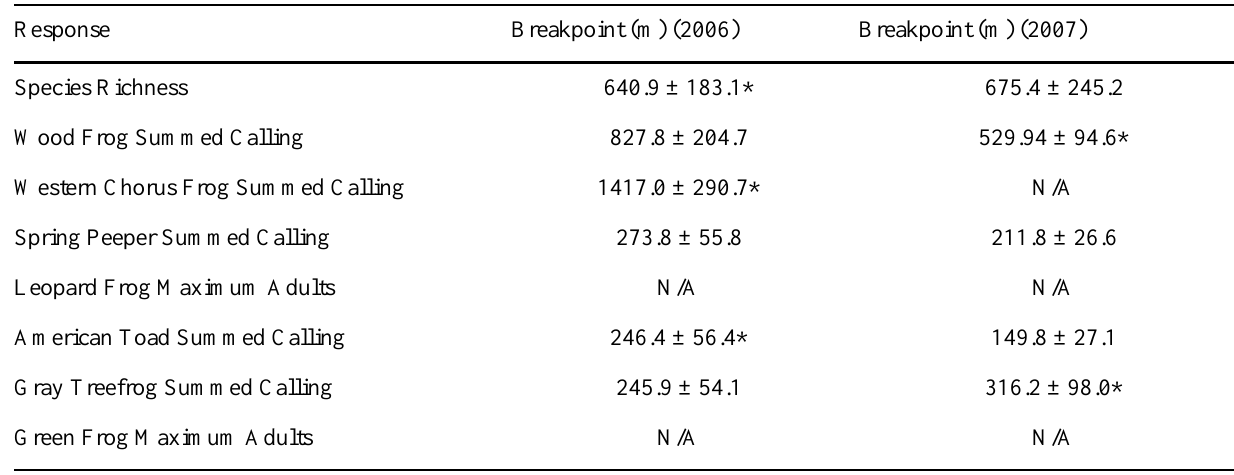
Table 4. Comparison of the threshold distance (± 1 SD) from 2006 and 2007 that the road effect zone of Highway 401 extended into the landscape for anuran relative abundance and species richness, as estimated from the breakpoints of piecewise regressions. For cases in which more than one breakpoint was estimated (*) (e.g., American toad in 2006; Figs. 3 and 4), only the estimate from the best-fitting model is shown. N/ A indicates that no statistically significant (P < 0.05) "difference in slope parameter" was present, or that no piecewise regression was attempted because a threshold was not apparent from visual examination of the data. A piecewise regression was not attempted for the chorus frog in 2007 because of the low number of presences (7) of this species in that